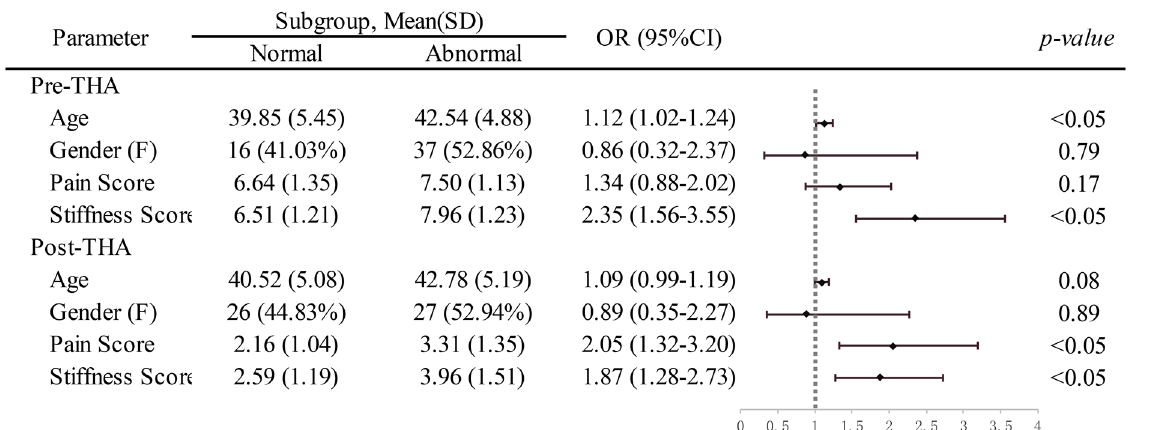
TABLE 5 Subgroup-speci fi c association of sexual function with age, gender, joint pain, and stiffness.